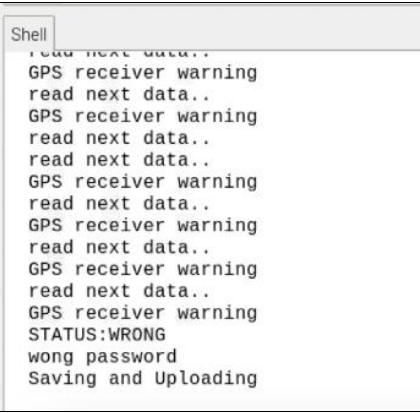
Figure 6. GPS testing results.